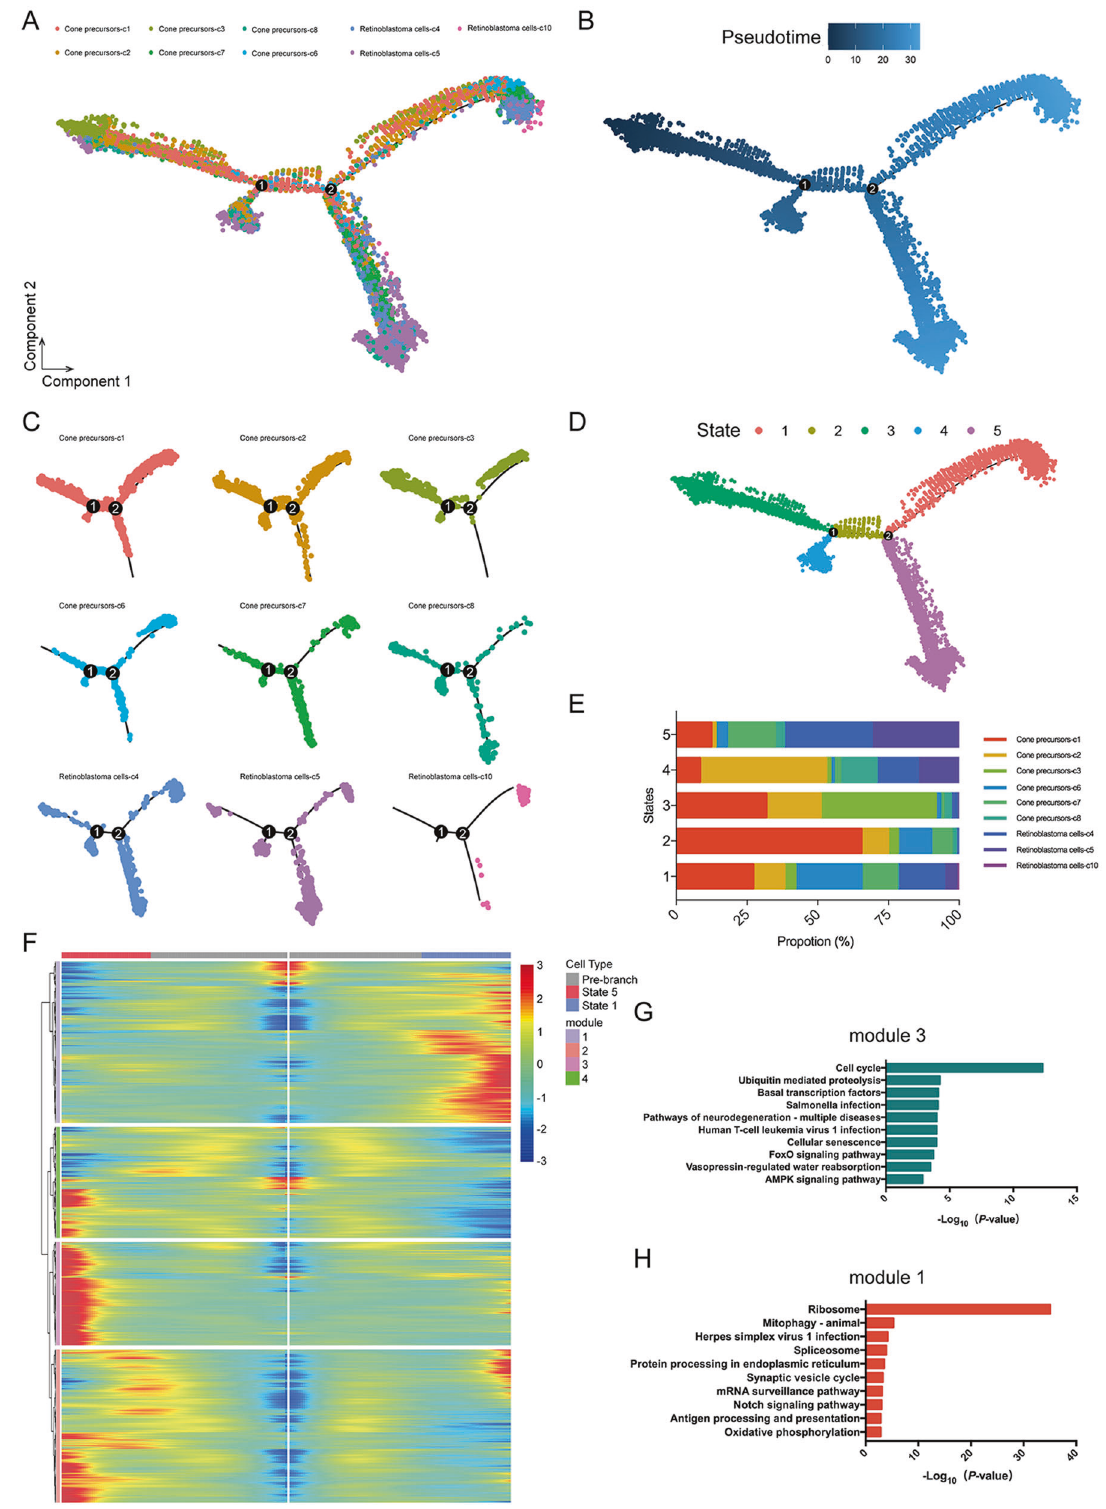
Fig. 2 Construction of cone precursors and retinoblastoma cells differentiation trajectories. A , B Trajectory analysis revealing the retinoblastoma progression, colour-coded according to cell clusters (all six subtypes of cone precursors and three subtypes of retinoblastoma cells). C Pseudotime trajectory analysis of individual clusters (c1, c2, c3, c4, c5, c6, c7, c8, c10). D The trajectory showed state- speci fi c progression patterns in retinoblastoma. E Composition of the clusters within each cell state. F Heatmap showing the ordering gene expression dynamics during the cellular-state transition process and expression dynamics. State-1 and state-5 reprogramming trajectories (including pre-branch) are shown on the right and left, respectively. G , H Heatmap of KEGG enrichment analysis enrichment by module 3 ( G ) and module 1 ( H ).